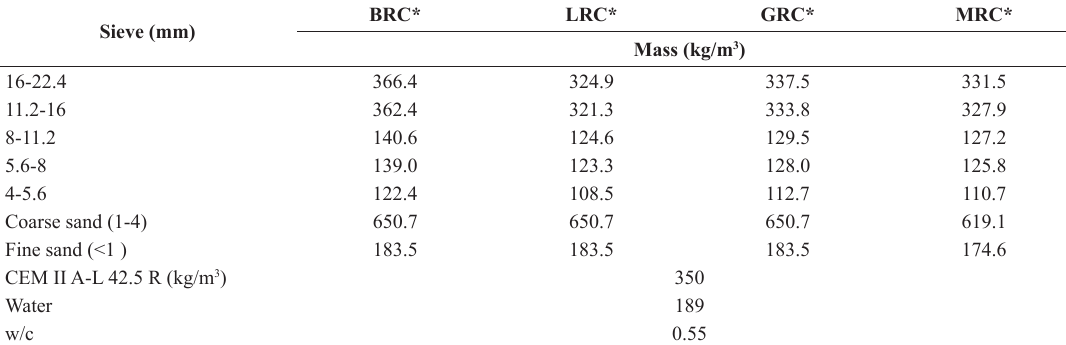
Table 1. RC composition (per m 3 ).